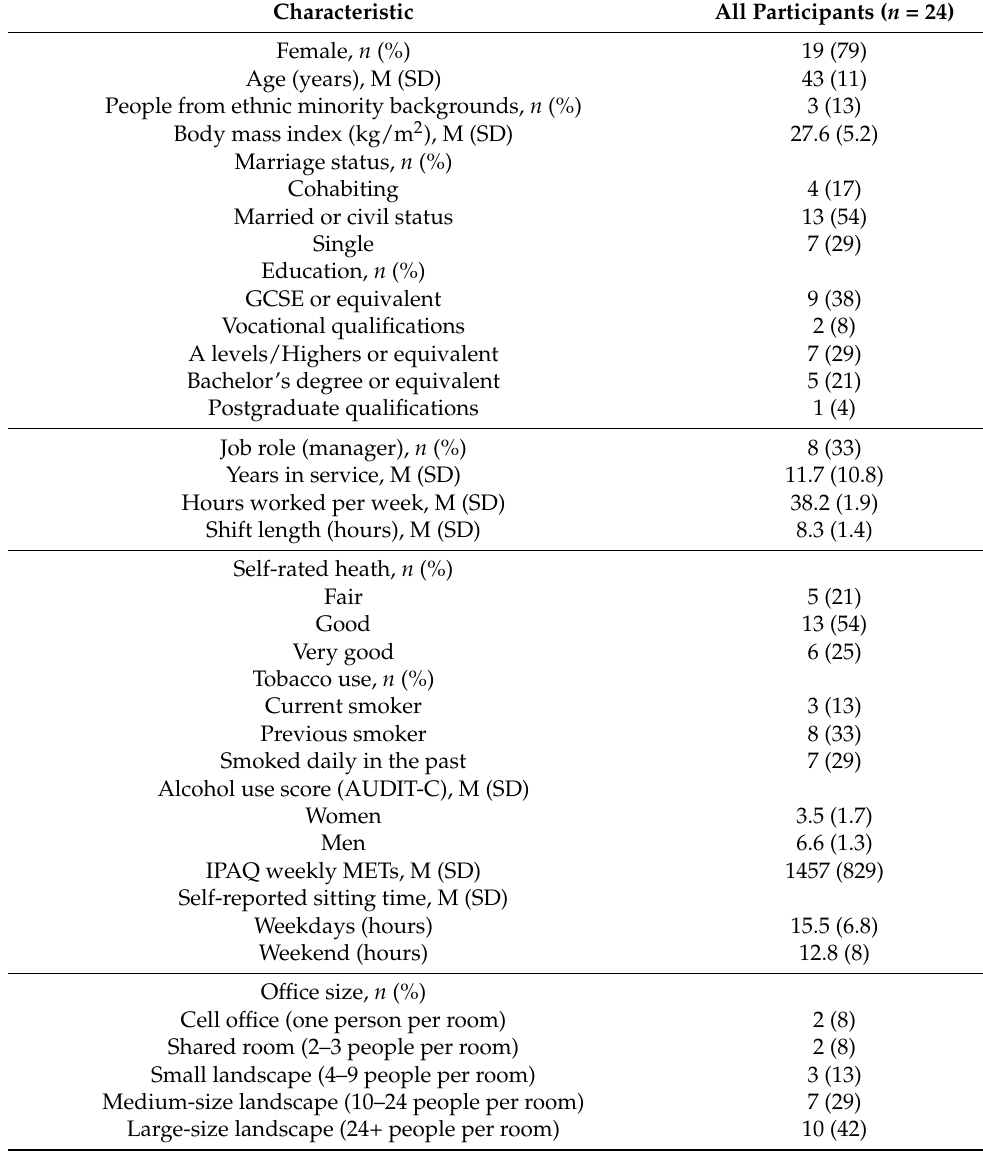
Table 2. Descriptive characteristics of police staff